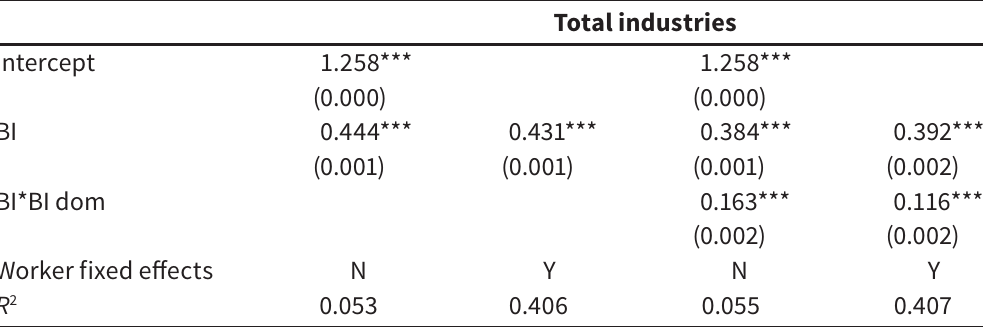
Number of industries worked regressed on